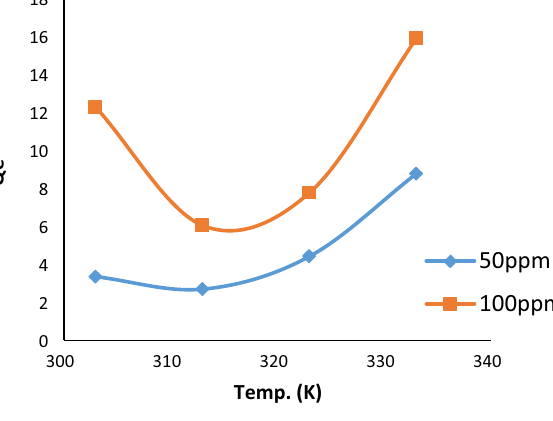
Fig. 8 a Temperature profile diagram for Cr(VI)//G, b tempera- ture profile diagram for Cr(VI)//, c temperature profile diagram of